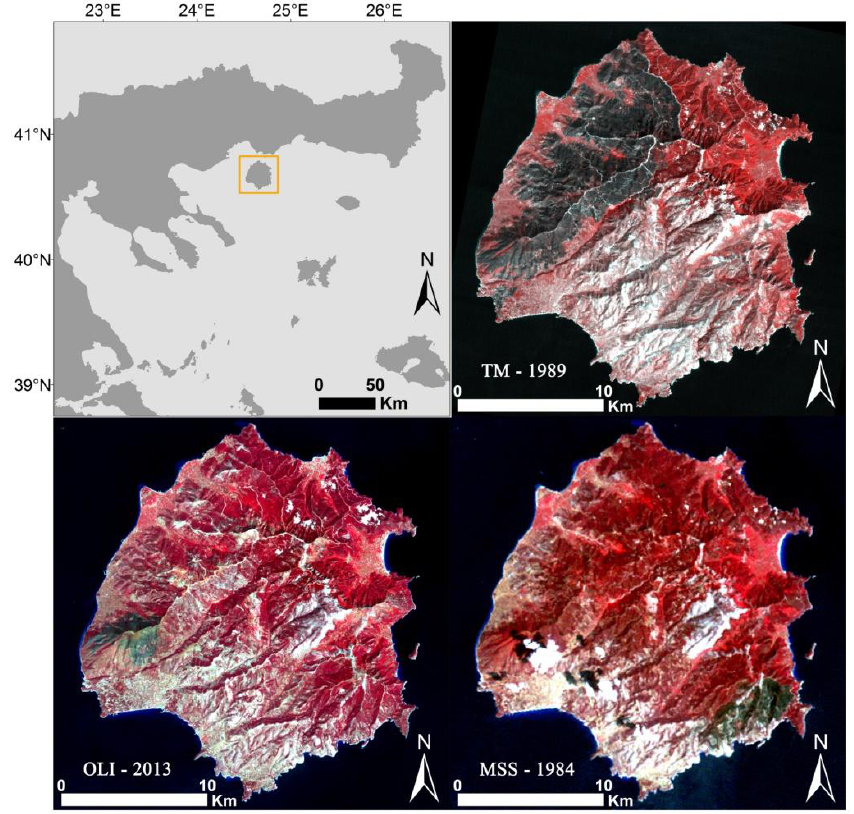
Figure 1. Location of Thasos Island and the Landsat images used in the